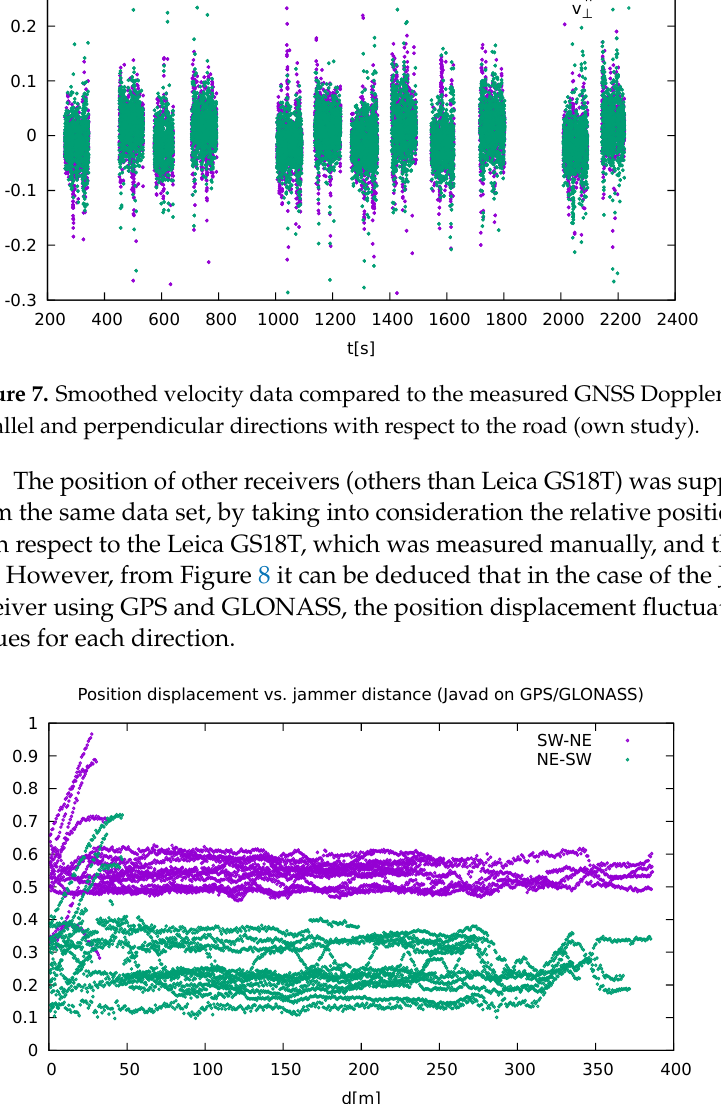
Figure 8. Discrepancy between the measured position and the calculated one for Javad Triumph LSA using GPS and GLONASS depending on the jammer distance (own study).